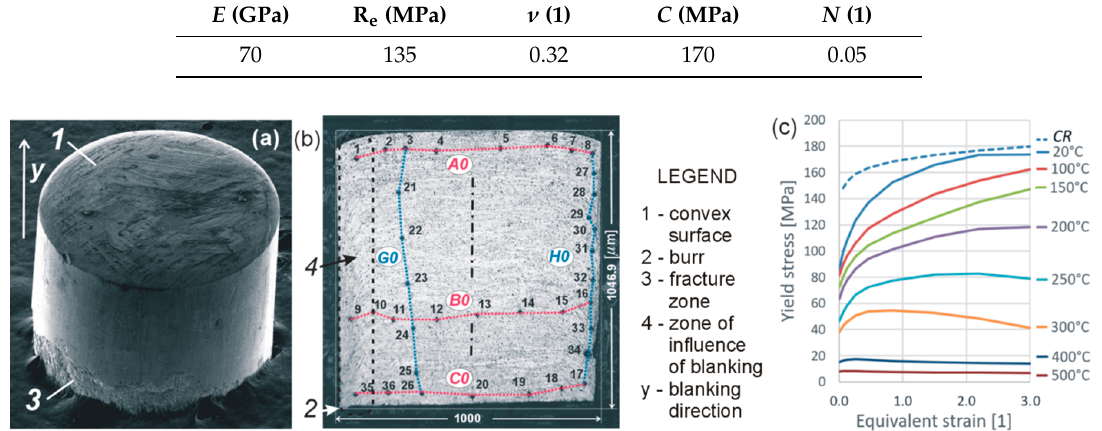
Figure 3. ( a ) SEM of specimen “S0”: ( b ) Cross-section with marked micro-hardness, further described in text; and ( c ) stress strain curves of used material in the mild state and at the state of experiment, CR.